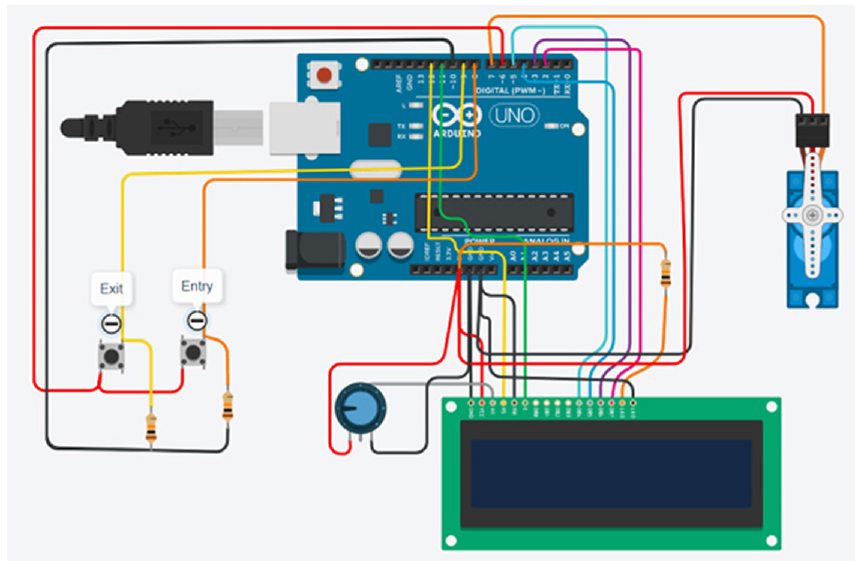
Fig. 15. Electrical scheme of digital parking at the Public University “Kadri Zeka” in